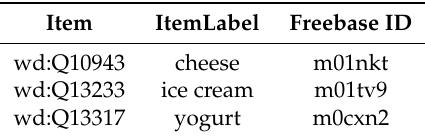
Table 1. Results for SPARQL